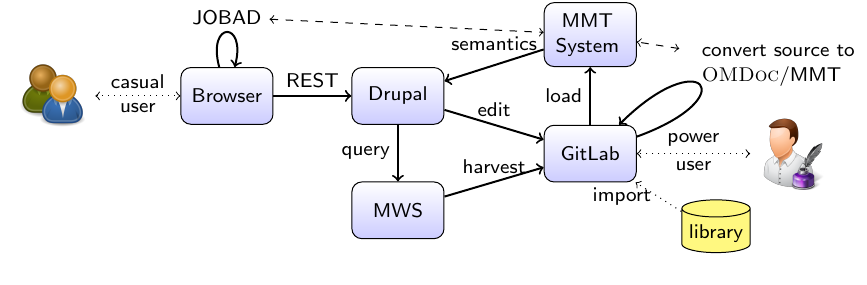
Fig. 5. The modular MathHub.info